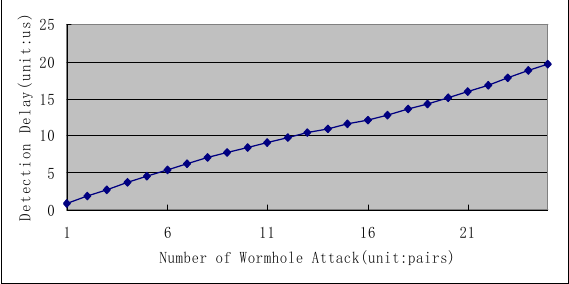
Fig.6. Detection Delay